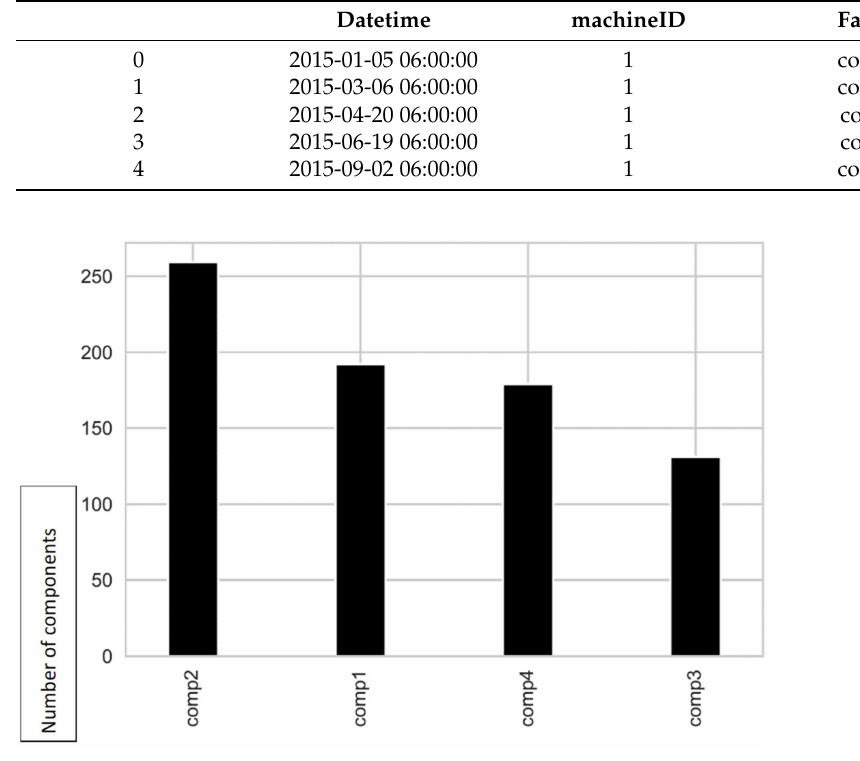
Figure 5. Representation of the number of components replaced, by type, due to the occurrence of a failure.